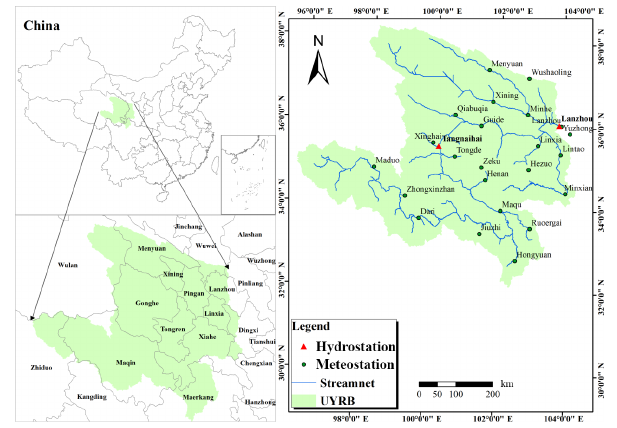
Figure 1. Location of the study area and the meteorological and hydrological stations